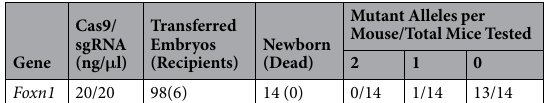
Table 1. CRISPR/Cas9-mediated Foxn1 gene targeting in NSI mice. Cas9 mRNA and sgRNA targeting Foxn1 were injected into fertilized eggs. The blastocysts derived from injected embryos were transplanted into foster mothers and newborn pups were obtained and genotyped. The number of total alleles mutated in each mouse is listed from 0 to 2.